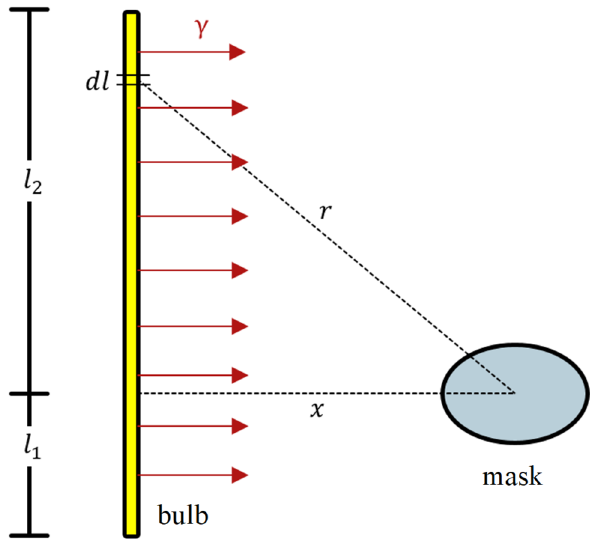
Figure 1. Approximate geometric orientation between the UV bulbs and